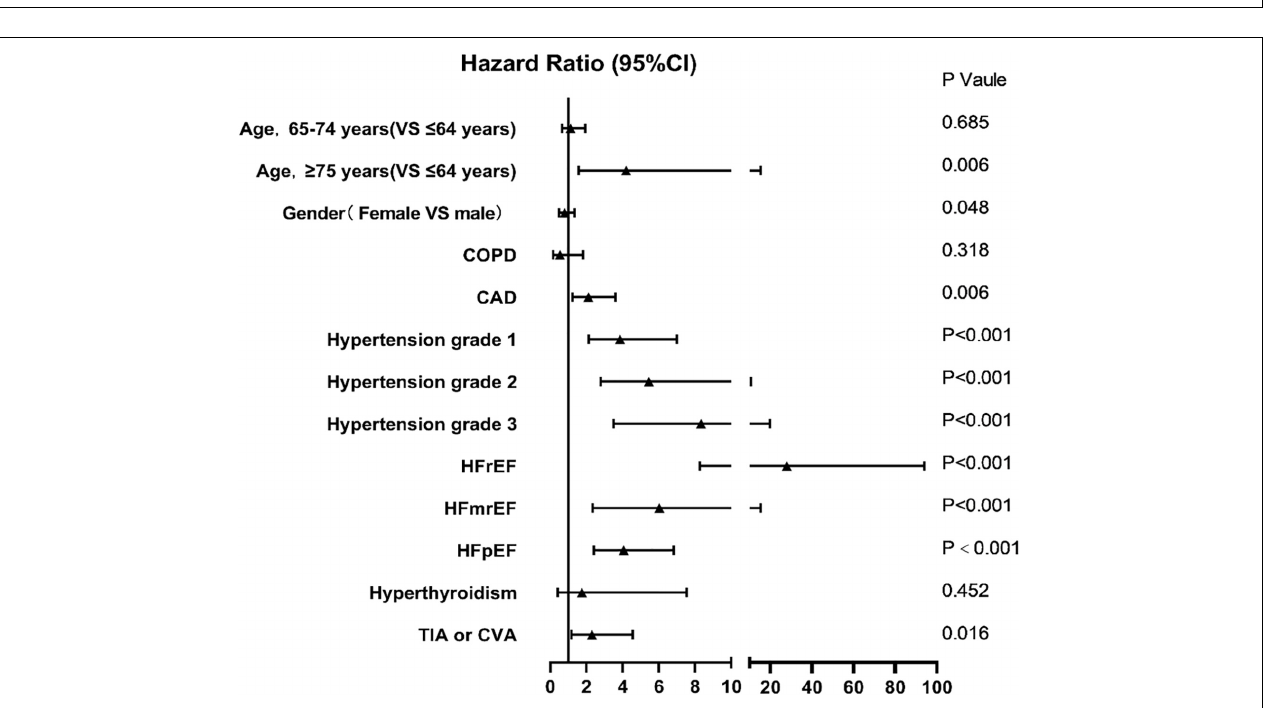
FIGURE 3 | Receiver operating characteristic curves for the C2HEST and HATCH score in predicting incident atrial fibrillation recurrence, and the DeLong test was used to compare the predictive power between C2HEST and HATCH score.